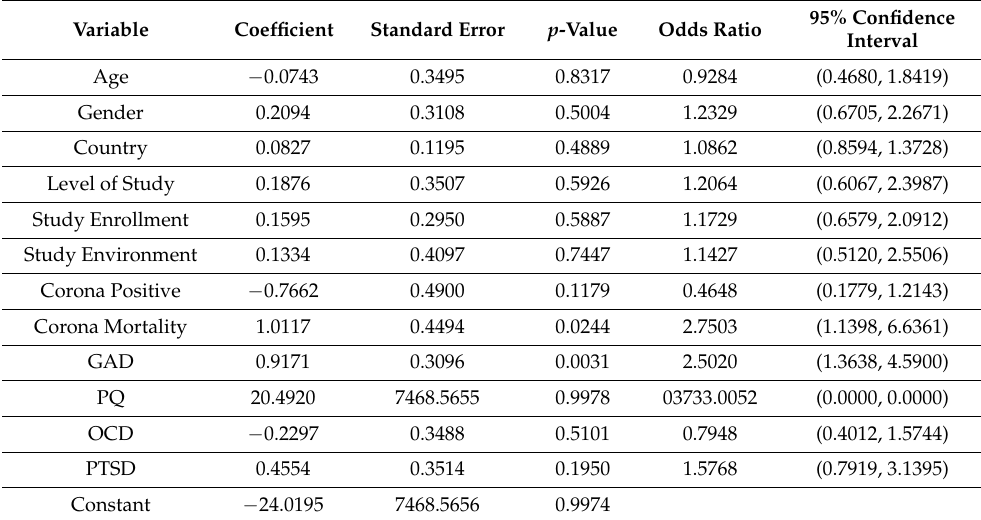
Table 6. Multiple binary logistic regression analysis of student diagnosed with any psychiatric disorder-related